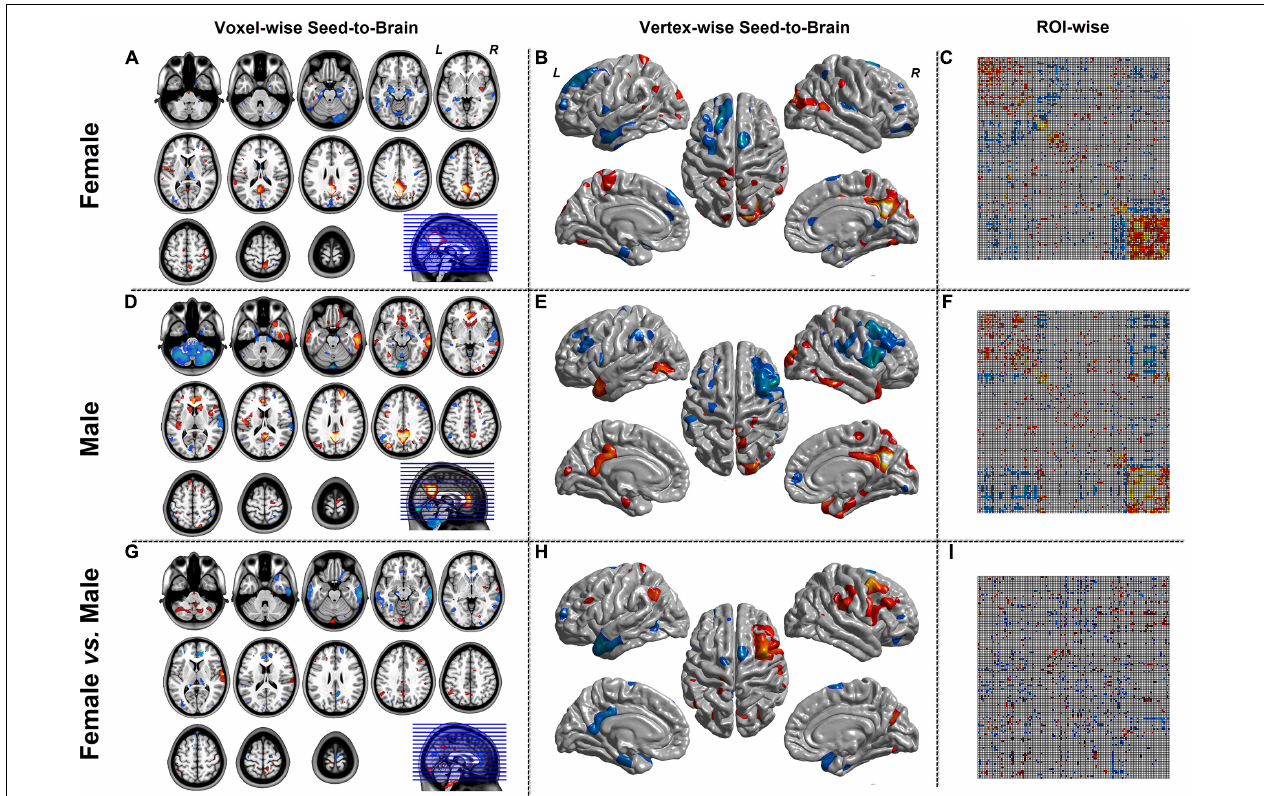
FIGURE 3 | The results of SCN mode. Panels (A,D,G) were the results of seed-to-brain connectivity of the GMV. Panels (B , E , H) were the results of seed-to-brain connectivity of thickness. Panels (C , F , I) were the results of ROI-wise connectivity of the GMV with the automated anatomical labeling (AAL) template. All results were set at the threshold of p < 0.05